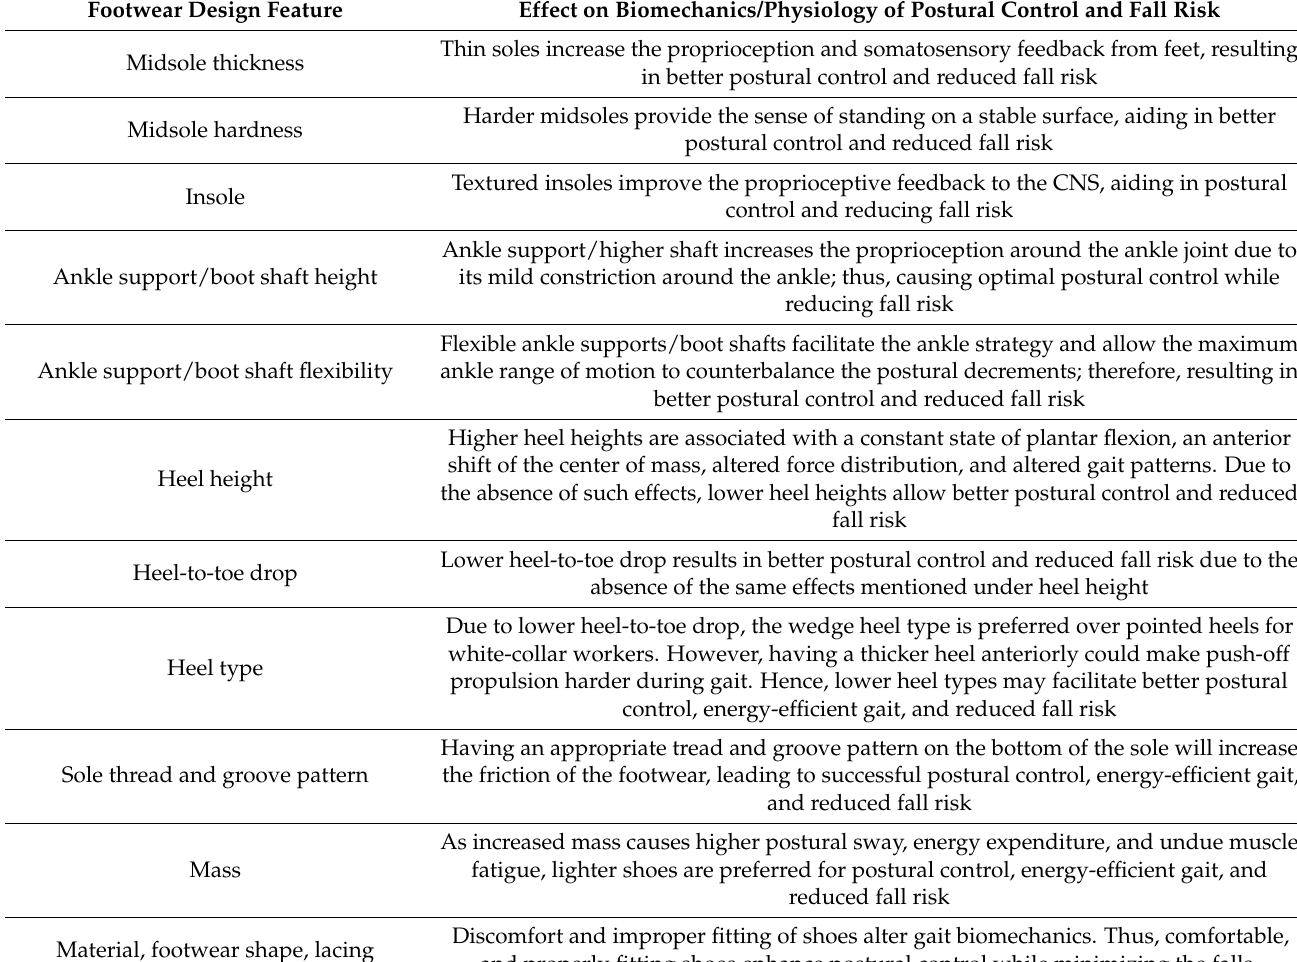
Table 3. Summary of design features impacting biomechanics and physiology of postural control and fall